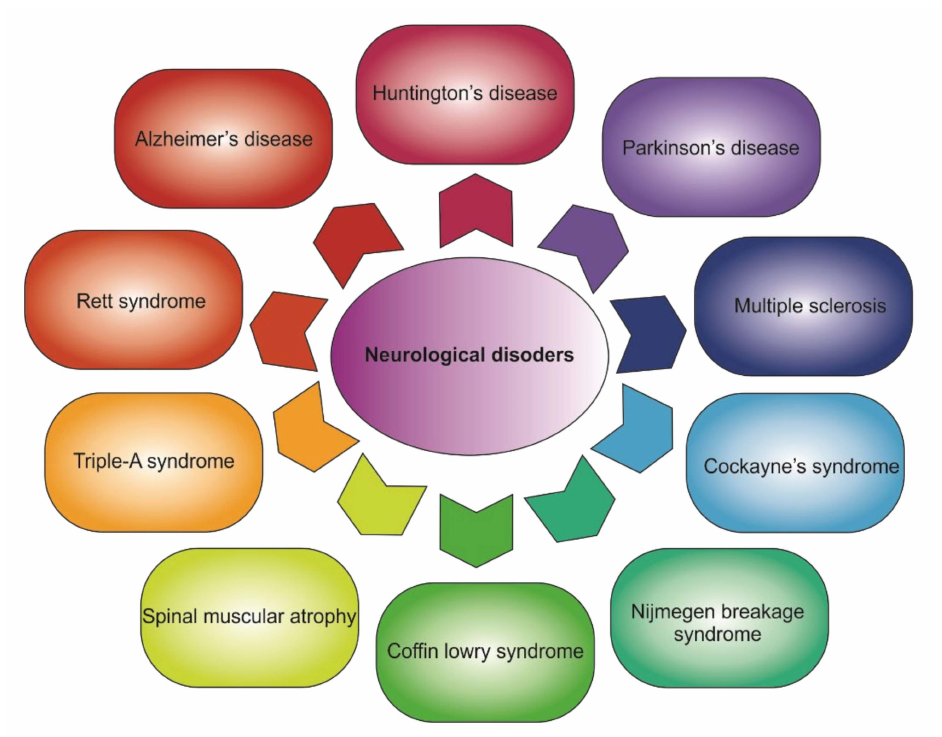
Figure 4. Common neurological